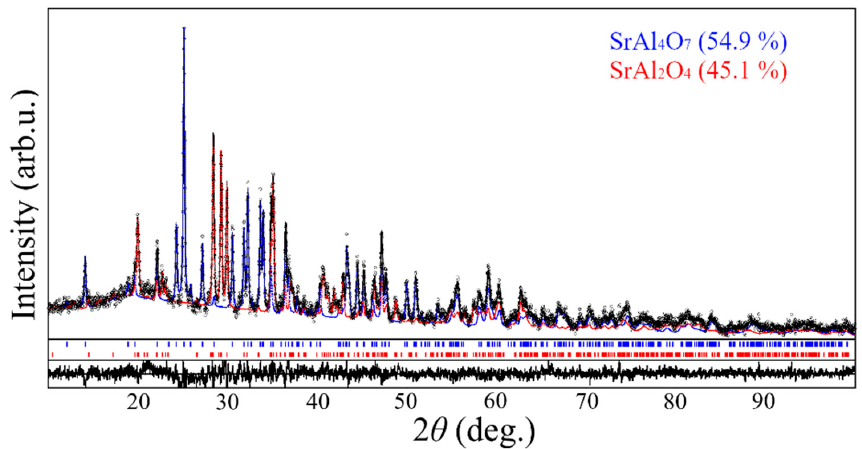
Figure 2. Graphical results of simultaneous two ‐ phase Rietveld refinement illustrating coexistence of two monoclinic phases—SrAl 4 O 7 (blue) and SrAl 2 O 4 (red) in the SrAl 4 O 7 :Cr 3+ sample, annealed at 1400 ° С .